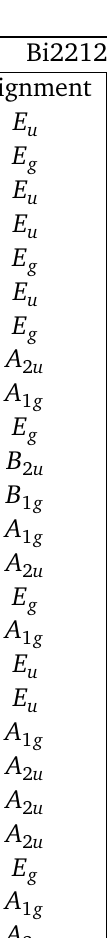
Table A3: Bi2212 optical mode frequencies and assignments at Γ . All mode frequen- cies are in cm − 1